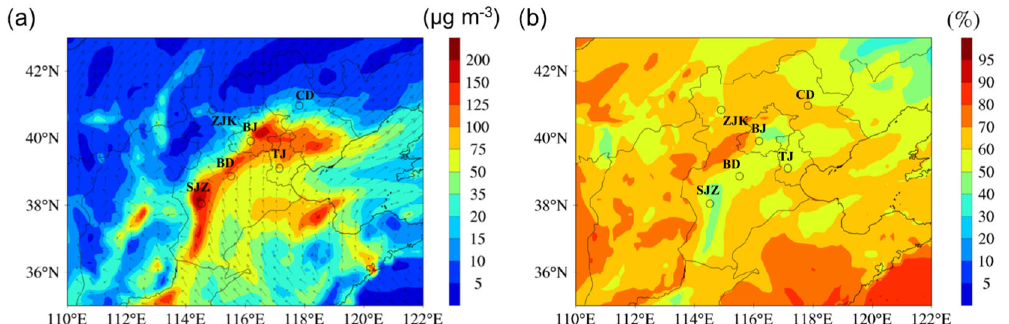
Fig. 4 Regional new particle formation and haze. Spatial distributions of a PM 2.5 mass concentrations and b fractions of accumulation mode particles from the growth of newly formed particles in Beijing – Tianjin – Hebei Area at 12:00 on September 14, 2015. The major cities of Chengde (CD), Zhangjiakou (ZJK), Beijing (BJ), Tianjin (TJ), Baoding (BD), and Shijiazhuang (SJZ) are